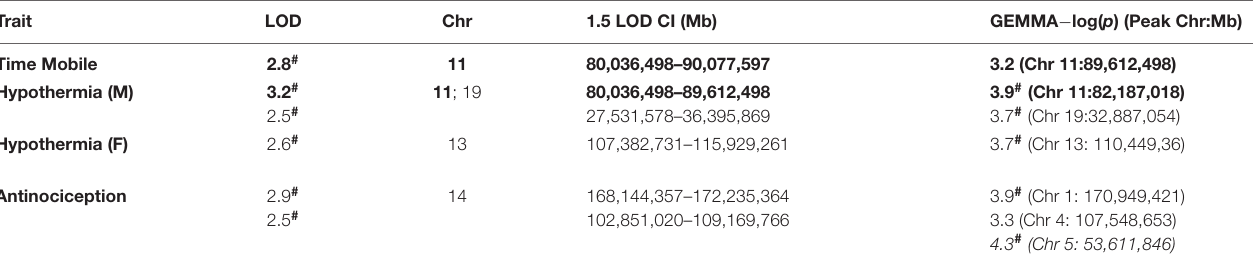
LOD, logarithm of the odds score based on traditional simple regression; Chr, chromosome; CI, confidence interval; #, meets suggestive genome-wide threshold; F, female; M, male. Bold text indicates overlapping QTL shared by mobility and hypothermia (male) traits and italicized text indicates QTL detected only using GEMMA.